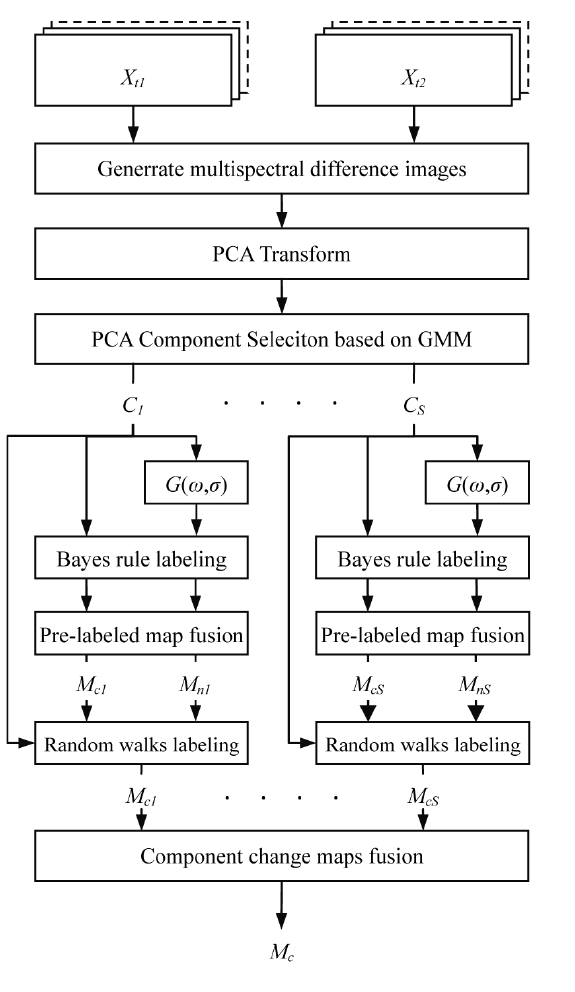
Figure 3. Flowchart of the proposed unsupervised change detection approach.